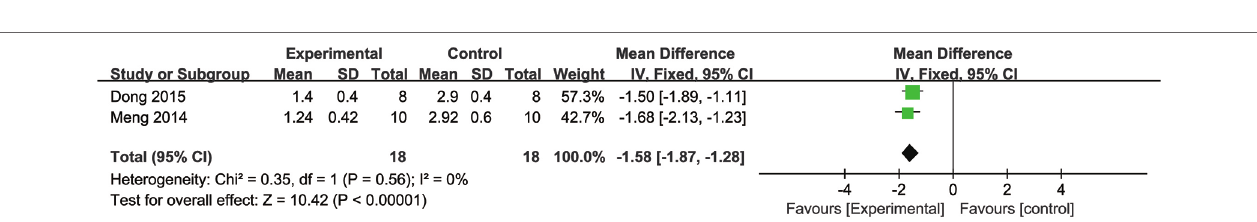
FIGURe 6 | The forest plot: effects of notoginsenoside R1 for reducing cerebral infarction volume compared with the control group (n = 33 per group).